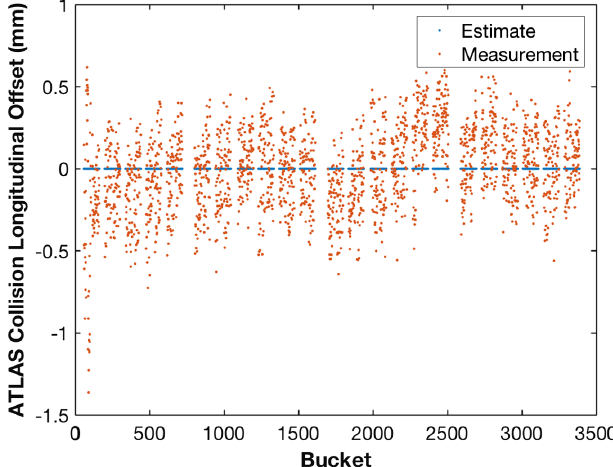
FIG. 23. Collision point longitudinal shift for ATLAS. Data and theoretical estimation.